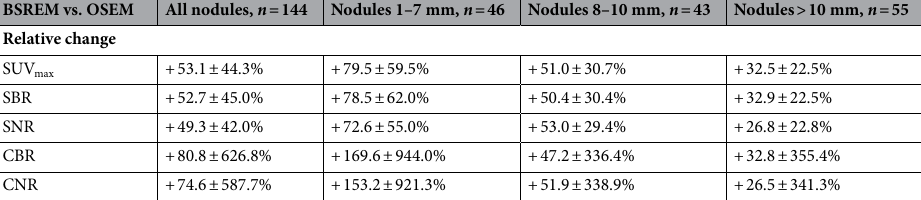
Table 3. Relative changes of maximum standardized uptake value (SUV max ), nodule signal-to-background ratio (SBR), nodule signal-to-noise ratio (SNR), contrast-to-background ratio (CBR), and contrast-to-noise ratio (CNR) in block sequential regularized expectation maximization (BSREM) compared to ordered subset expectation maximization (OSEM) reconstructions as reference. Values are given as mean ± standard deviation.